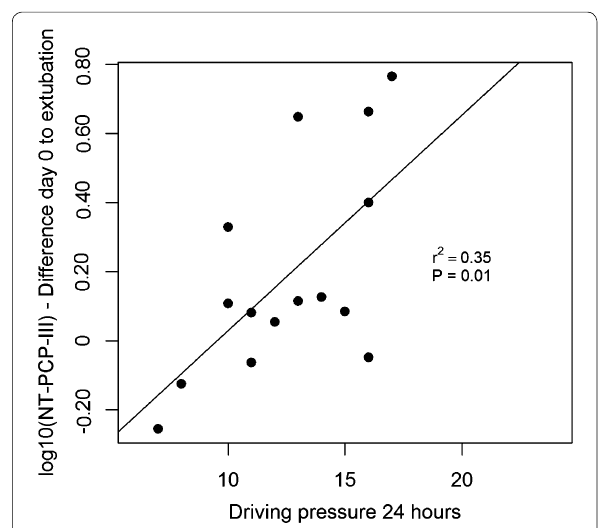
Fig. 4 Relationship between driving pressure and log10 N-terminal-peptide type III procollagen (NT-PCP-III) difference between extubation day and day 0 of acute respiratory distress syndrome